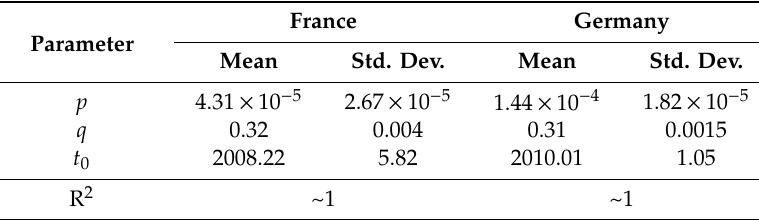
Table 2. Bass di ff usion model parameter estimates.